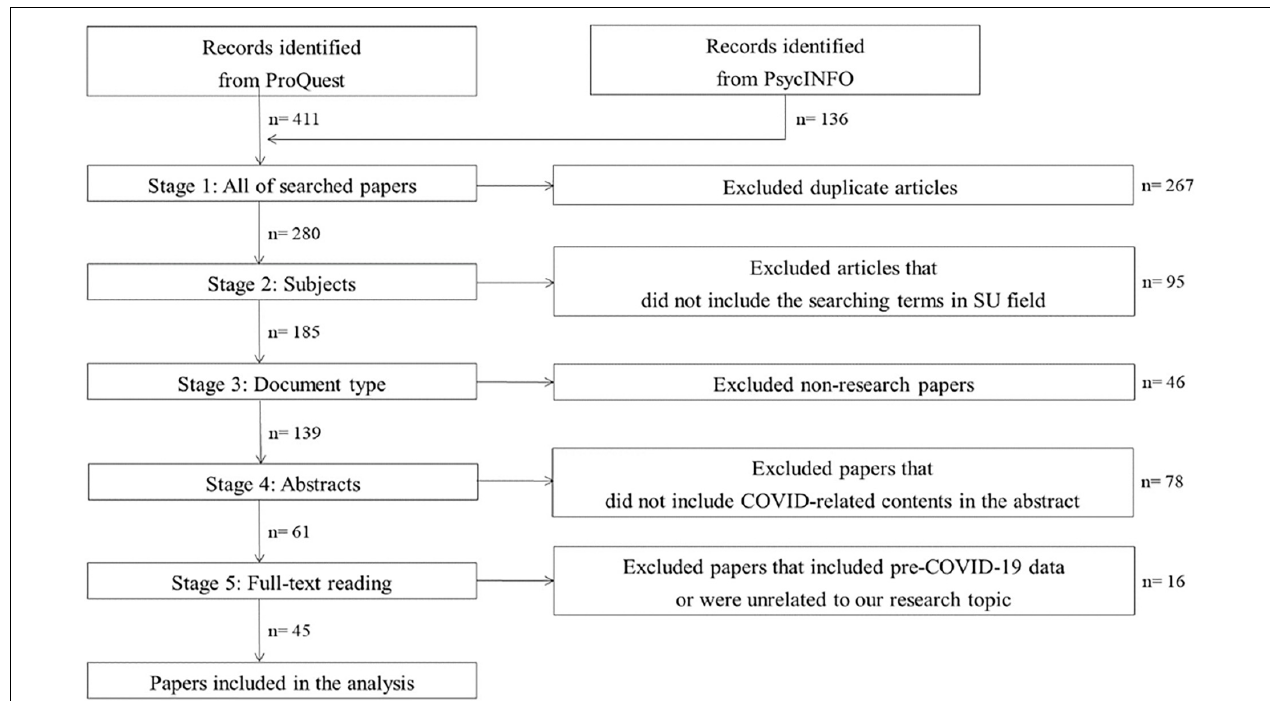
FIGURE 1 | Research